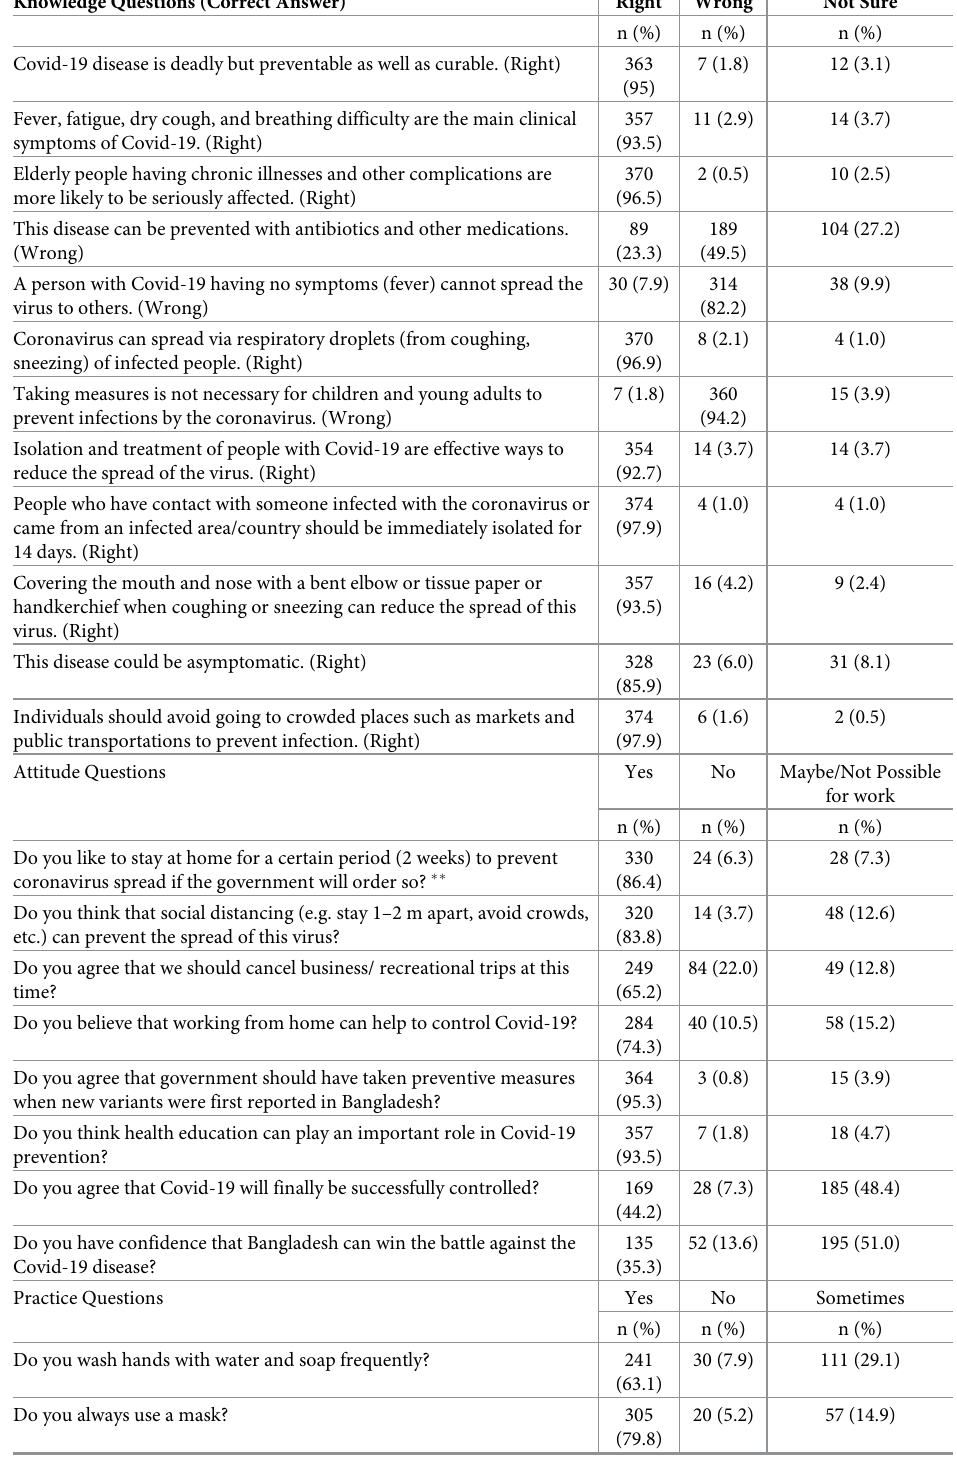
n (%) n (%) n (%) 7 (1.8) 12 (3.1) (95) 357 11 (2.9) 14 (3.7) (93.5) 370 2 (0.5) 10 (2.5) (96.5) 89 189 104 (27.2) (23.3) (49.5) 30 (7.9) 314 38 (9.9) (82.2) 370 8 (2.1) 4 (1.0) (96.9) 7 (1.8) 360 15 (3.9) (94.2) 354 14 (3.7) 14 (3.7) (92.7) 374 4 (1.0) 4 (1.0) (97.9) 357 (93.5)